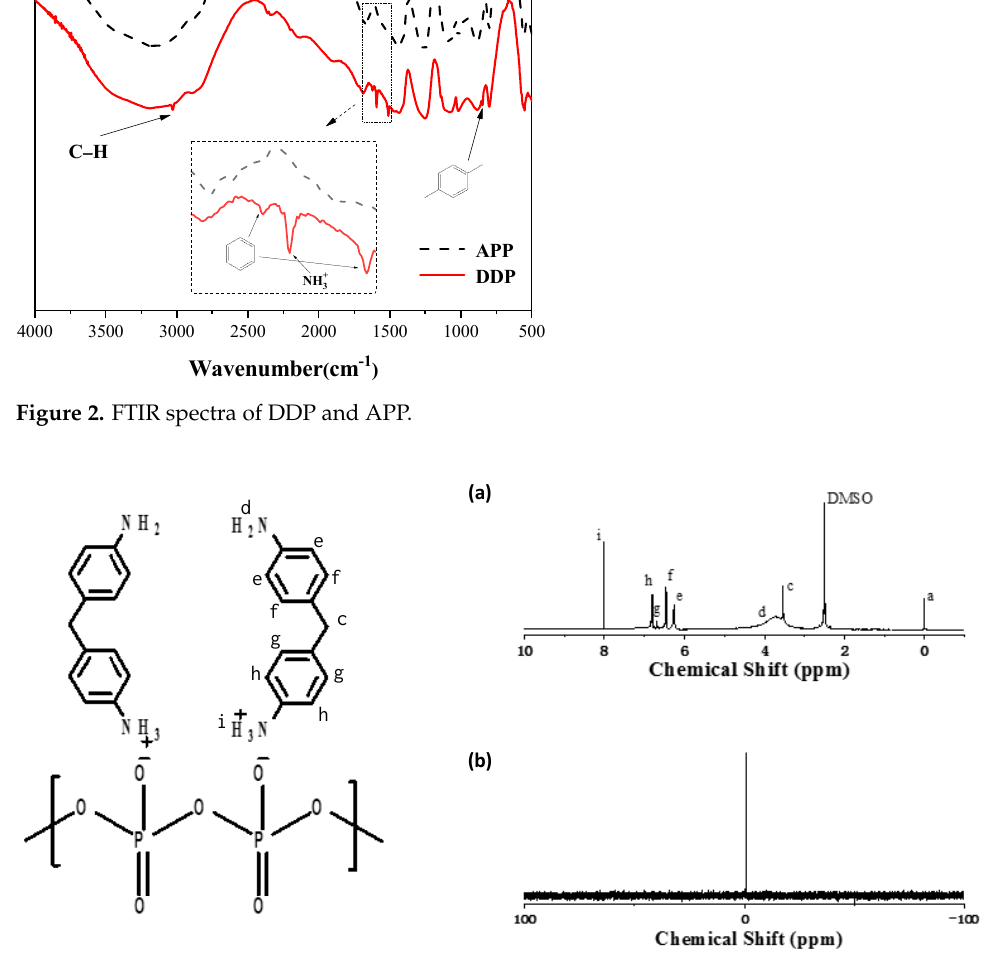
Figure 3. 1 H NMR ( a ) and 31 P NMR ( b ) spectra of DDP.